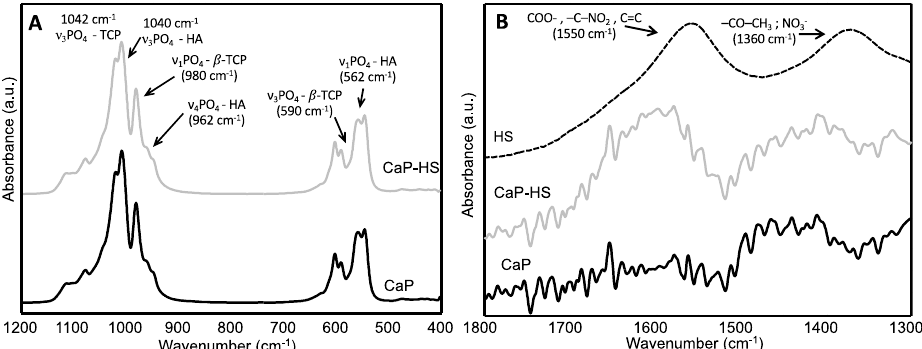
Figure 3. FT-IR spectra of CaP, CaP–HS and HS. The range of the spectra where the main IR bands of HA and β -TCP appear (1200–400 cm − 1 ) is reported on the left ( A ), while a magnification of the FT-IR spectra in the region where the typical IR bands of HS (1800–1300 cm − 1 ) occur is reported on the right ( B ).